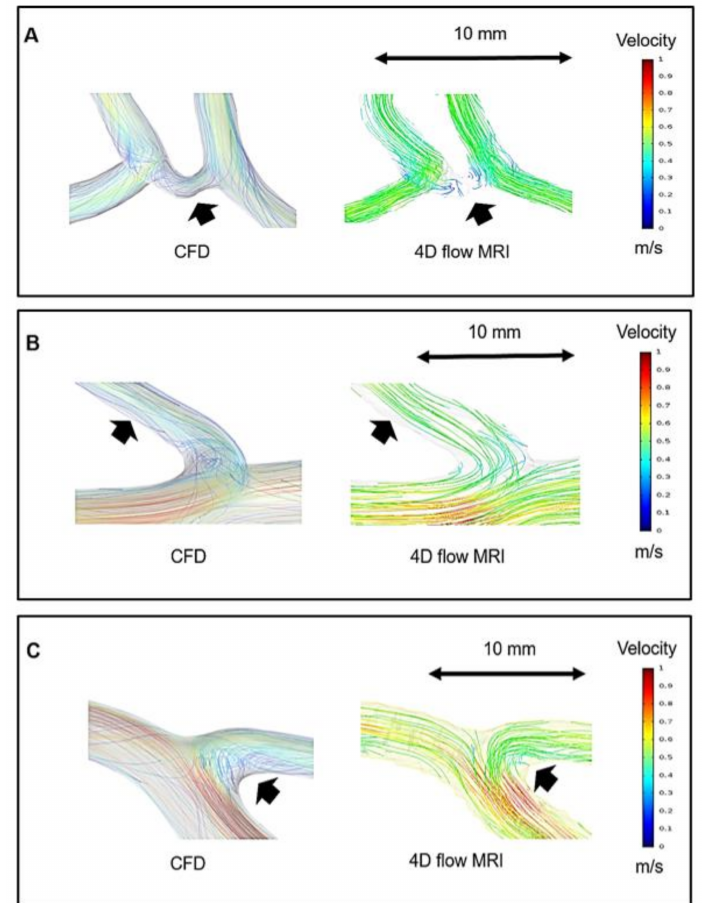
Figure 3. The differences in blood flow visualization between CFD and 4D flow MRI. ( A ) The blood flow in the anterior communicating artery (ACoA) is better visualized in CFD. ( B ) Low flows near the vessel wall are better captured by CFD. ( C ) Transitional flows at the ICA bifurcation visualized by CFD are of higher quality. The same velocity scale bar with color was applied for all the images ranging from 0–1 m/s.